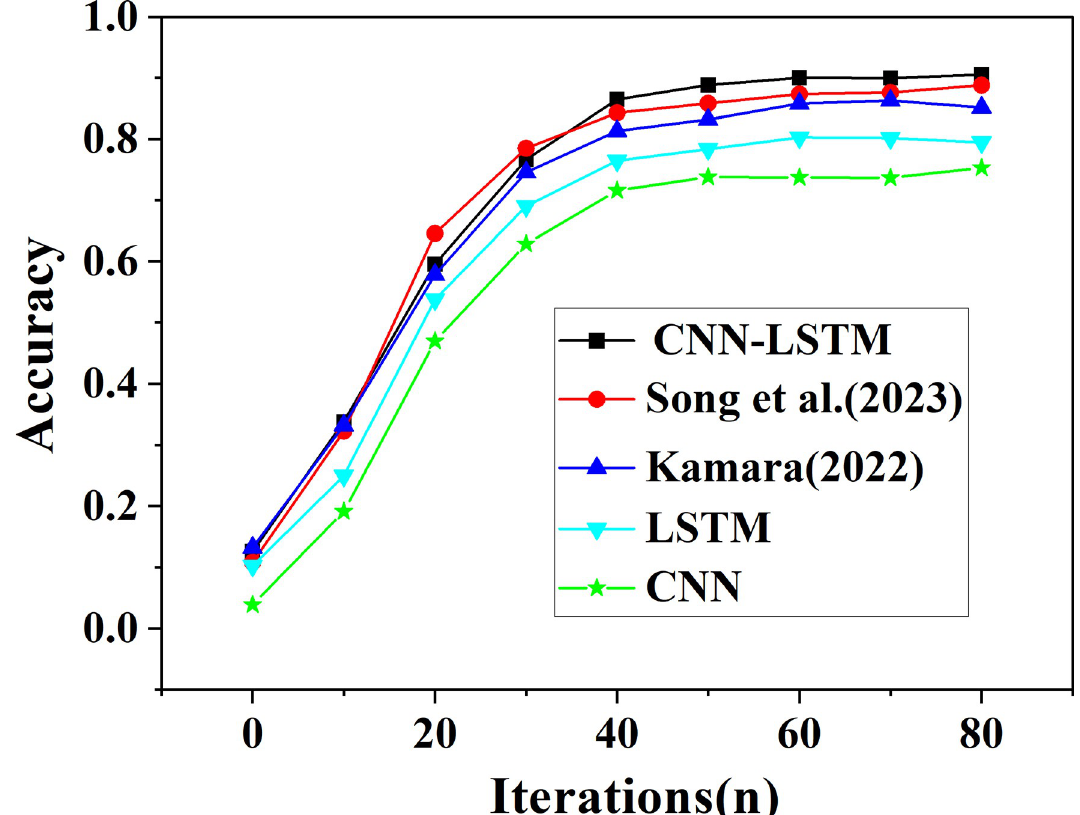
Fig 9. Influence curve of stock prediction accuracy with increased iterations under different